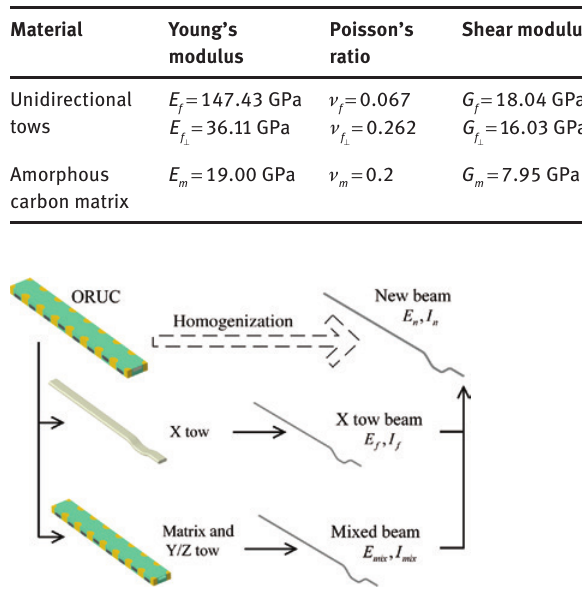
Table 2: Constituent material properties for C/C composites.